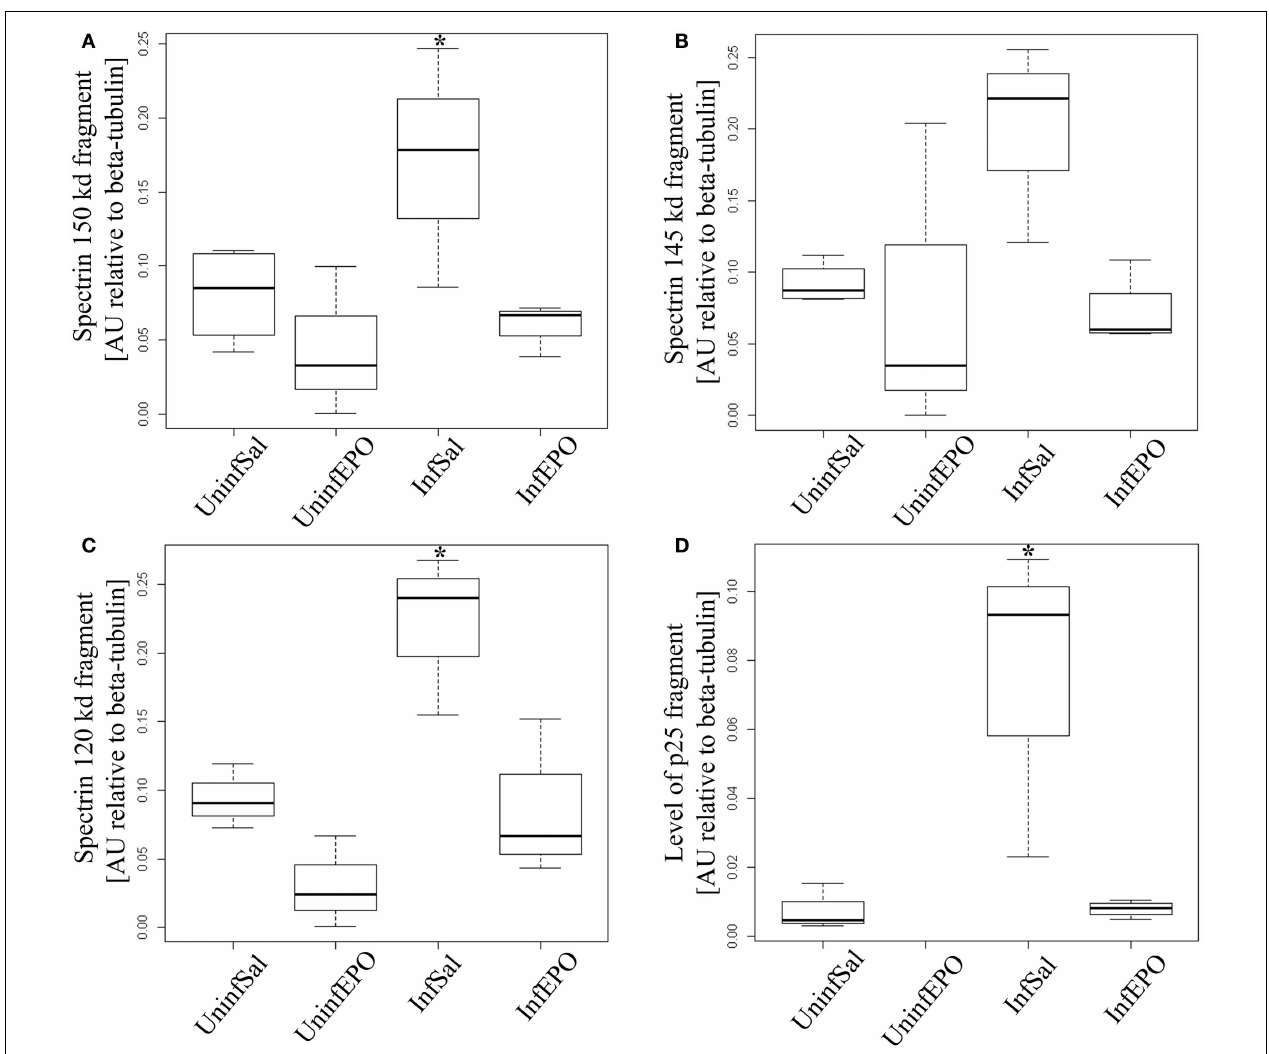
specific for caspase-3 activity was markedly increased in InfSal mice ( p < 0.01). (D) p35 is cleaved by calpain activity into a smaller fragment, p25. This fragment was not detectable in UninfEPO mice, but was significantly increased in InfSal mice ( p < 0.05). Box plots show median values and interquartile ranges.Whiskers showTukey hinges; open circles are outliers. Asterisks denote significant deviations from uninfected, saline-treated